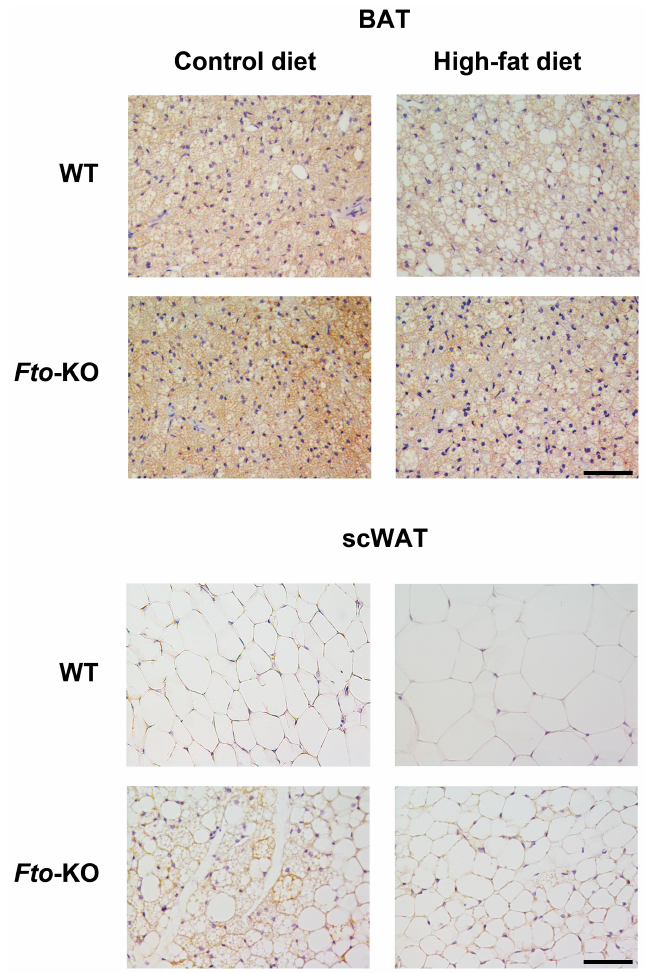
Figure 1. Uncoupling protein 1 (UCP1) immunohistochemistry of interscapular brown adipose tissue (BAT) and subcutaneous white adipose tissue (scWAT). WT, wild-type mice; Fto -KO, Fto -knockout mice. Scale bars are 60 µm and images are a representative of two to three different mice in each group.